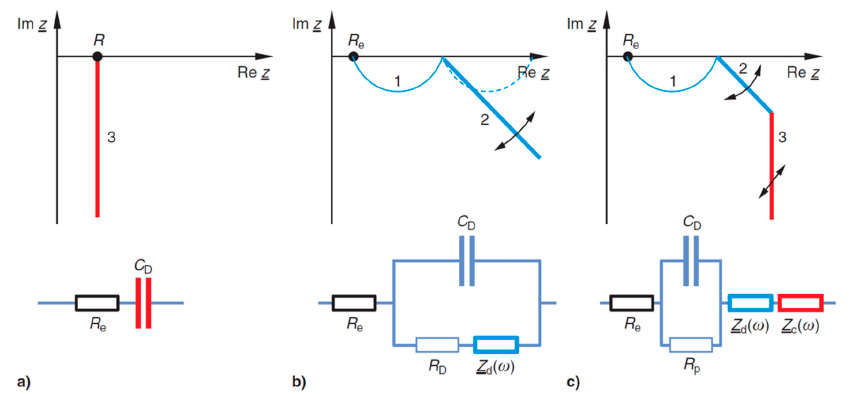
Figure 1. General equivalent circuits and impedance spectra of electrochemical storage devices (mathematical convention): ( a ) charge-transfer, ( b ) diffusion in mesopores and micropores (grain boundaries), ( c ) diffusion impedance in macro pores at a blocking interface.